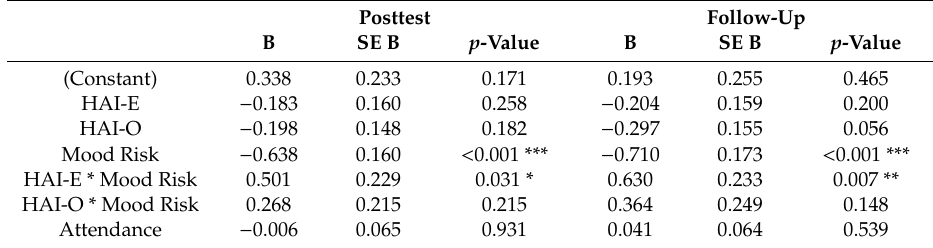
Table 2. Regression analyses modeling moderation effects of mood risk and treatment condition on student’s SELFREGULATION of learning and study strategies . Posttest Follow-up